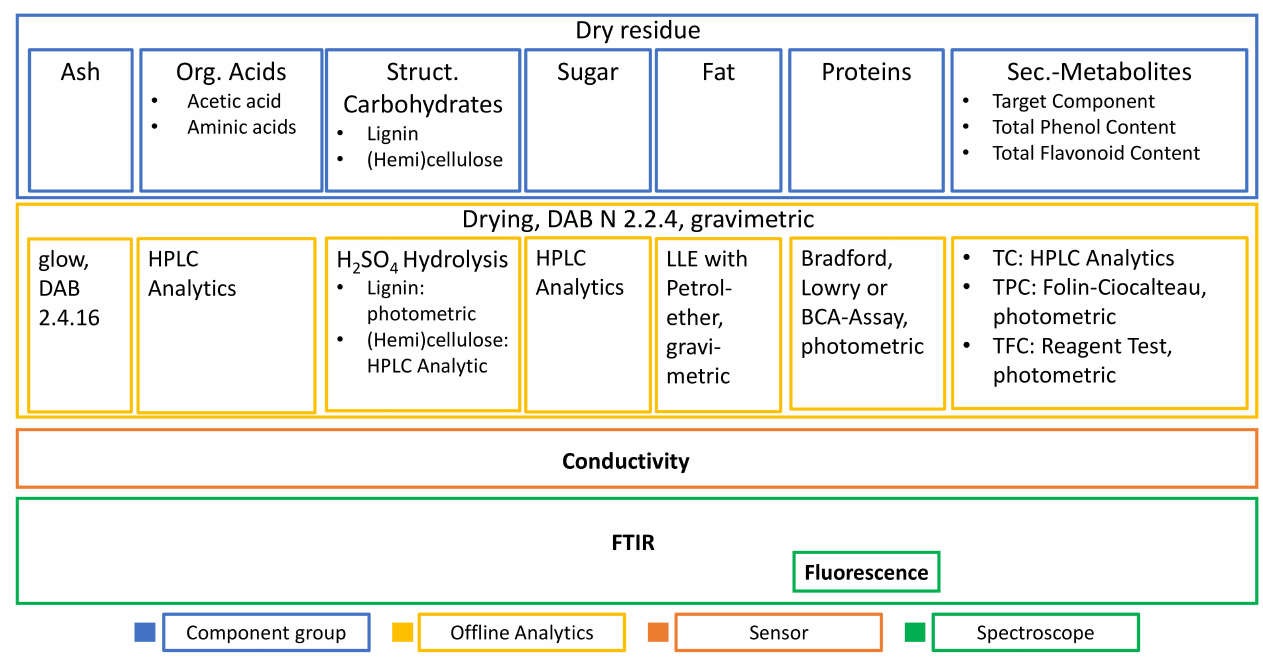
Figure 16. Updated overview of component groups and corresponding offline and online analytics, based on results in this